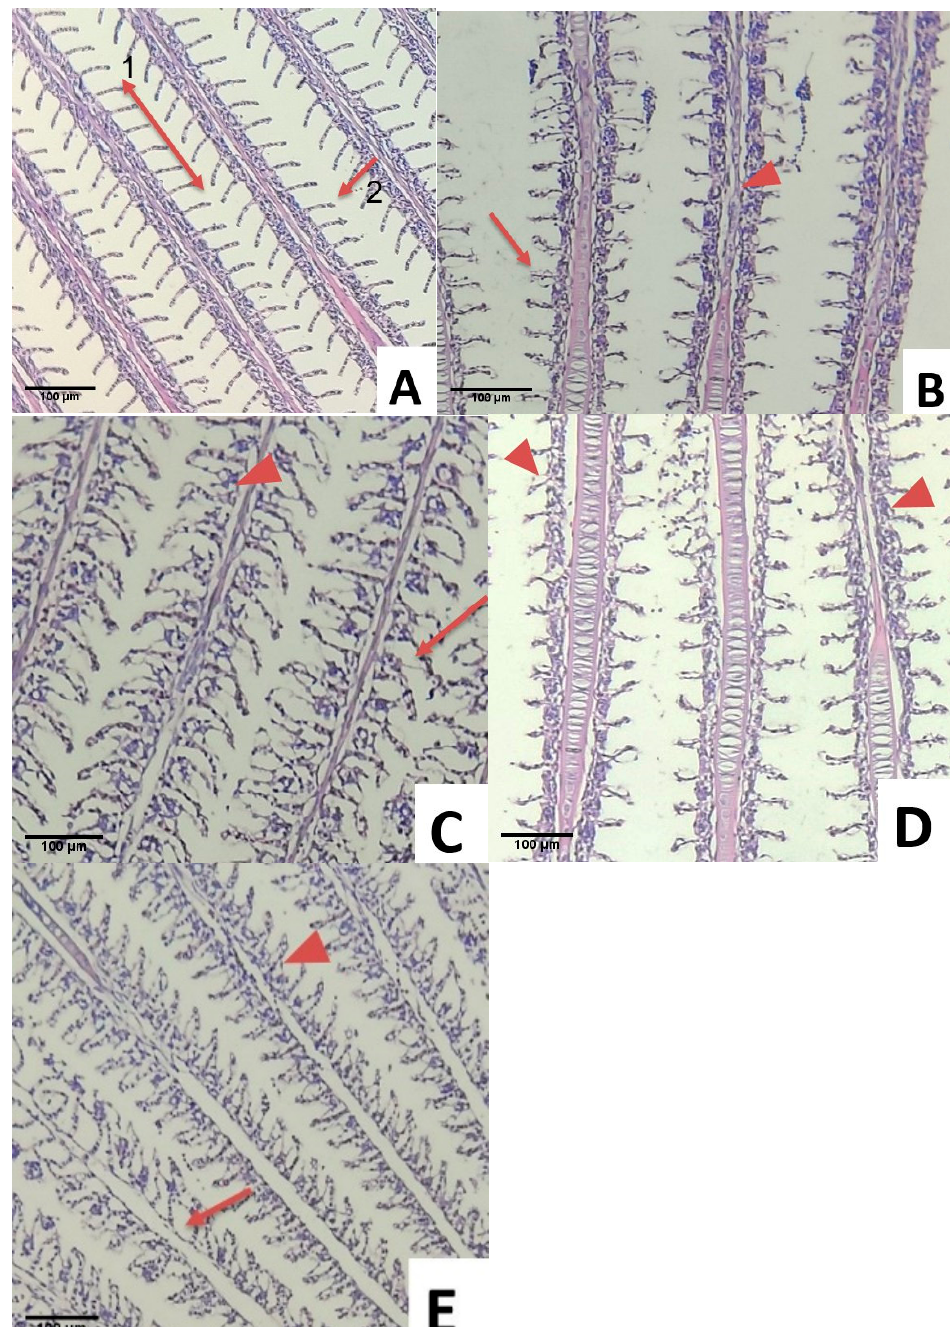
Figure 4. Histological changes in the gills of fish infected with Streptococcus agalactiae ( A ). Normal gill filaments in C (1: secondary lamella, 2: filament epithelium), ( B ). Vacuolation of interstitial space edema (thin arrow) and lamellar dilation (short arrow) in S1 ( Streptococcus agalactiae ), ( C ). Vacuolation of interstitial space edema (thin arrow) and lamellar dilation (short arrow) in S2 (Biofloc + Streptococcus agalactiae ). ( D ). Aneurism on lamella (short arrow) in S3 (Biofloc + MG1 + Streptococcus agalactiae ), ( E ). Aneurism (Short arrow) and lifting of respiratory epithelium (thin arrow) in S4 (Biofloc + MP + Streptococcus agalactiae ). (HE staining, 100× magnification).